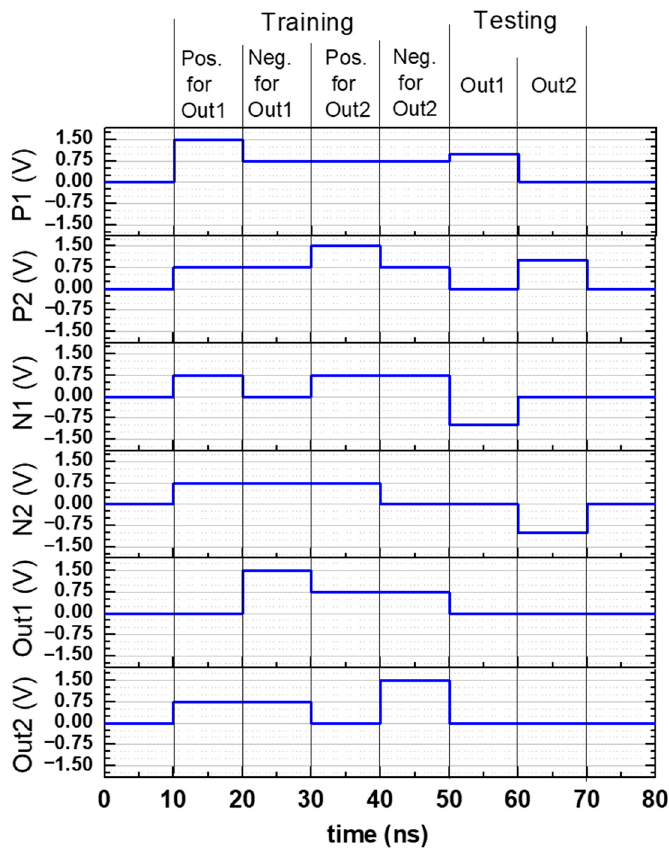
Figure 7. Input signal voltages at training and testing procedures.